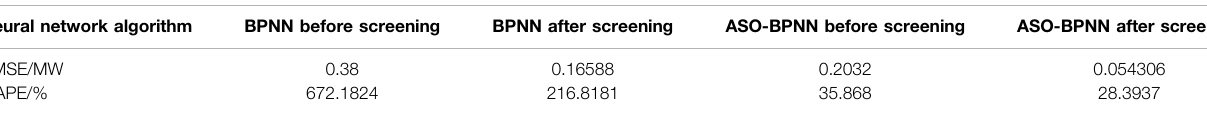
TABLE 3 | Prediction error data of each neural network